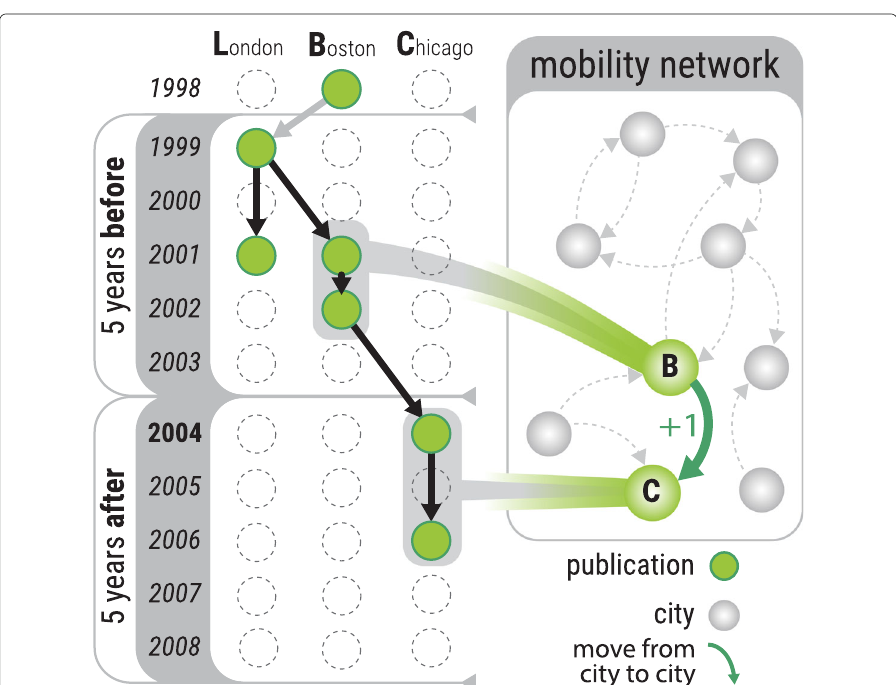
Fig. 1 Creating the mobility network from M EDLINE publications. The scientific publications by a single author are illustrated as a sequence of green circles from top to bottom. Each publication has a time (in rows) and location (in columns) associated with it. We take a buffer time (i.e. 5 years) before and after a candidate move from Boston ( B ) to Chicago ( C ) in 2004. In this example, we identify Boston as the source, since it is the longest sequence within the window and closest to the end of the move year. Similarly, the destination is Chicago since it is the only observed city in the second window. Each move is tracked in a similar way